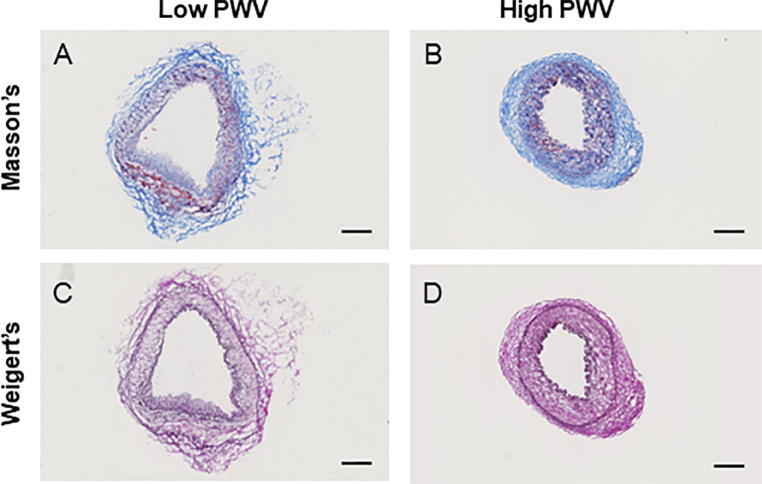
Histological sections for the IMA (A) and (B) Masson’s staining for collagen in low (A) and high PWV (B) groups (C) and (D) Wiegert’s staining for elastin in low (C) and high PWV (D) groups. Scale bar indicates 200 μm.